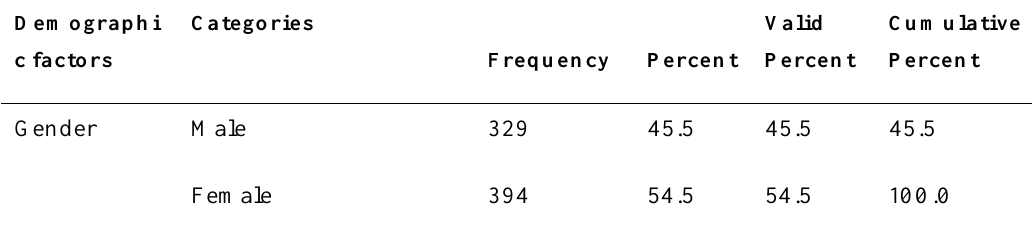
Number of Respondents Based On Gender, Age and Degree of